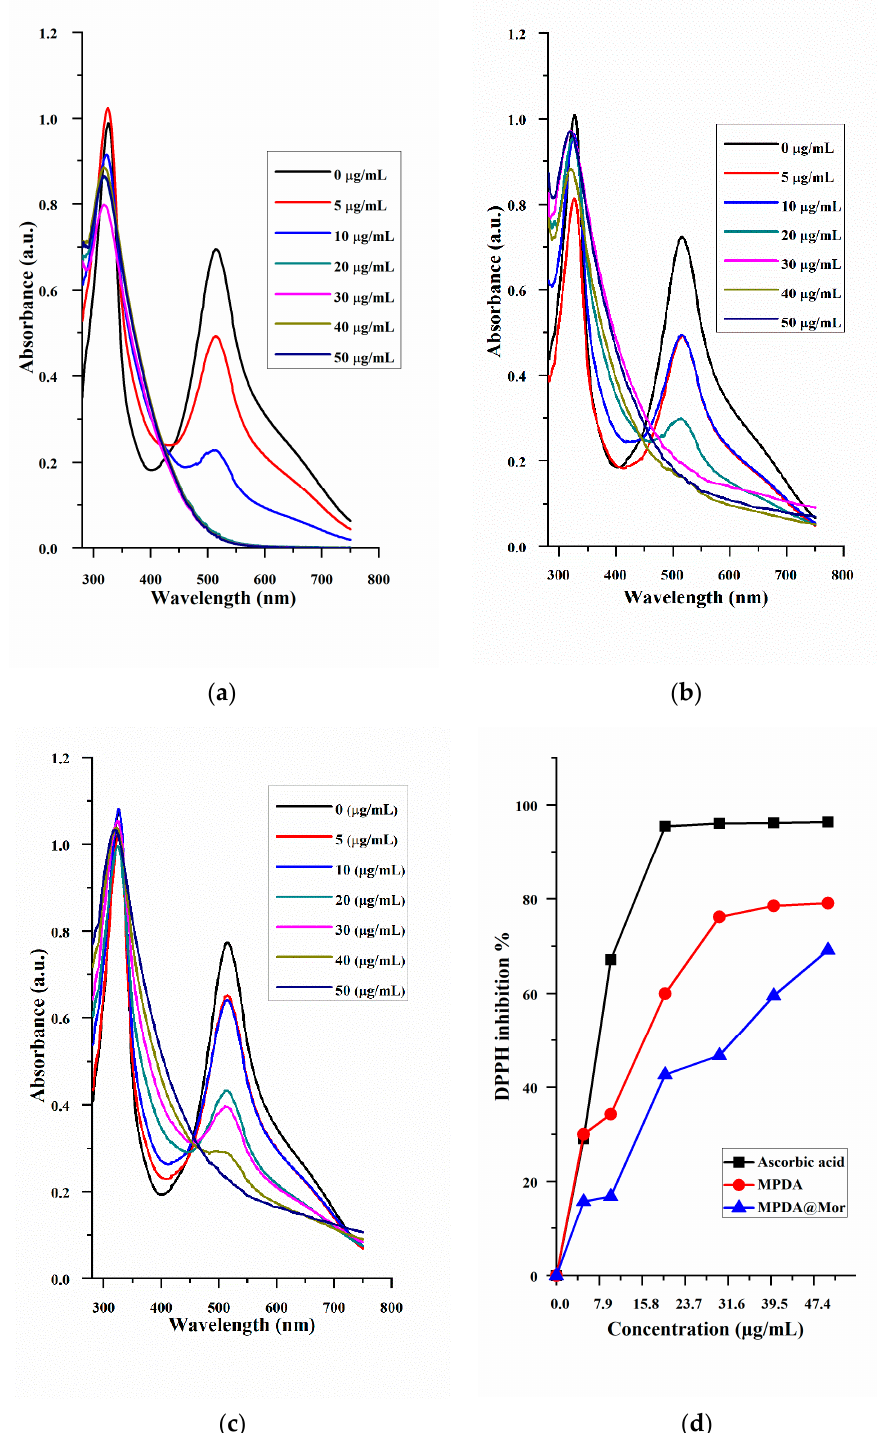
Figure 4. UV-vis absorption spectra signifying the DPPH free radical scavenging efficacy of ( a ) ascorbic acid. ( b ) MPDA and ( c ) MPDA@Mor. ( d ) DPPH free radical scavenging percentage at different concentrations of ascorbic acid, MPDA, and MPDA@Mor.